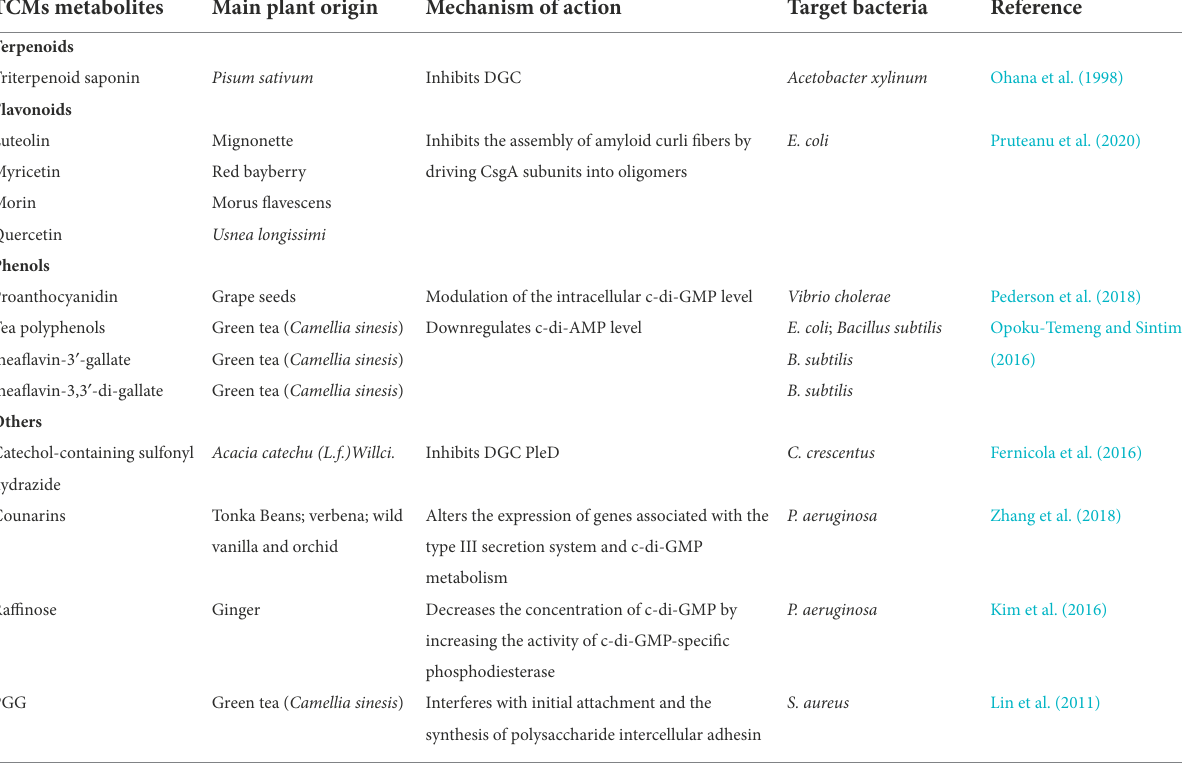
TABLE 2 Different classes of anti-biofilm TCMs metabolites and their mechanisms of action via bacterial second messengers ( − related) signaling